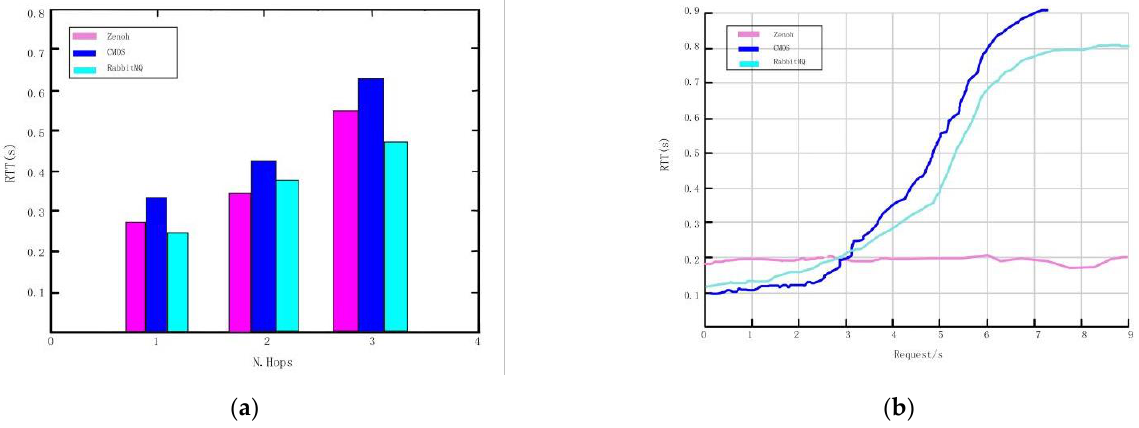
Figure 12. Data collection. ( a ) Graph of round-trip times for requests across network hops. ( b ) Request round trip time graph.